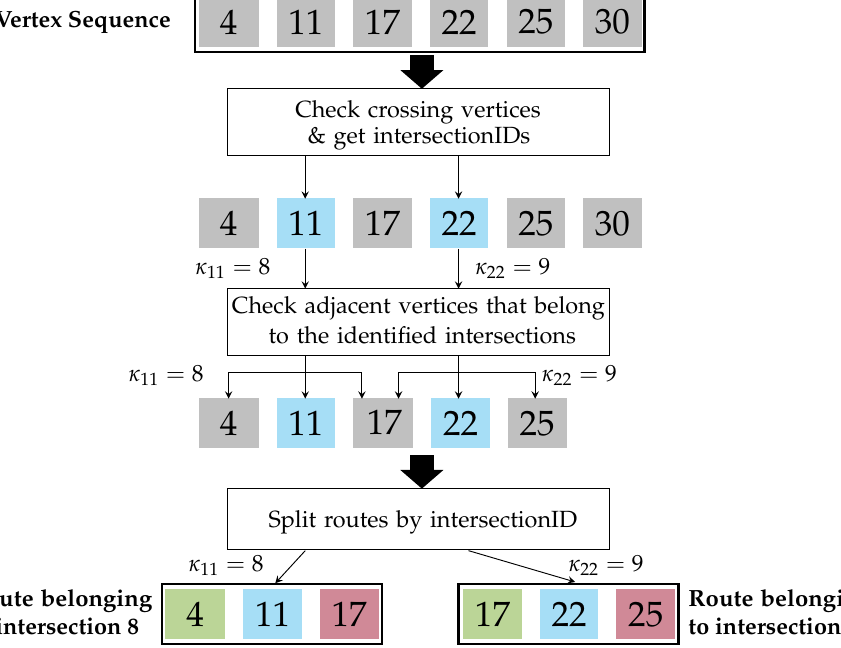
Figure 7. Graphical depiction of the method used to extract intersection routes. Crossing vertices are Figure 7. Shown is a graphical depiction of the method to extract intersection routes. With blue, the marked in blue, incoming vertices in green, and outgoing vertices in crossing vertices; with green, the incoming vertices; and with red, the outgoing vertices.